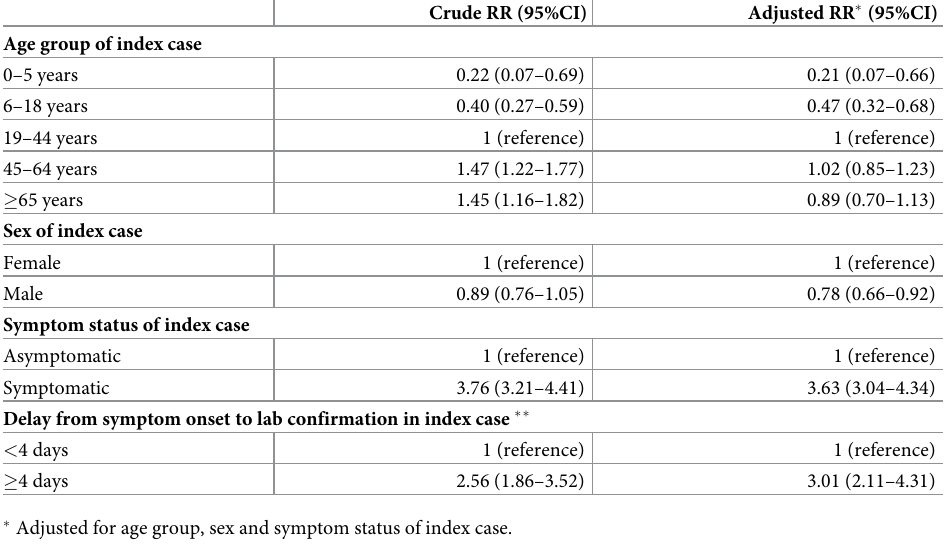
Table 3. Risk of SARS-CoV-2 infection among 16715 contacts of 956 index cases (Karnataka, India; up to 1 June